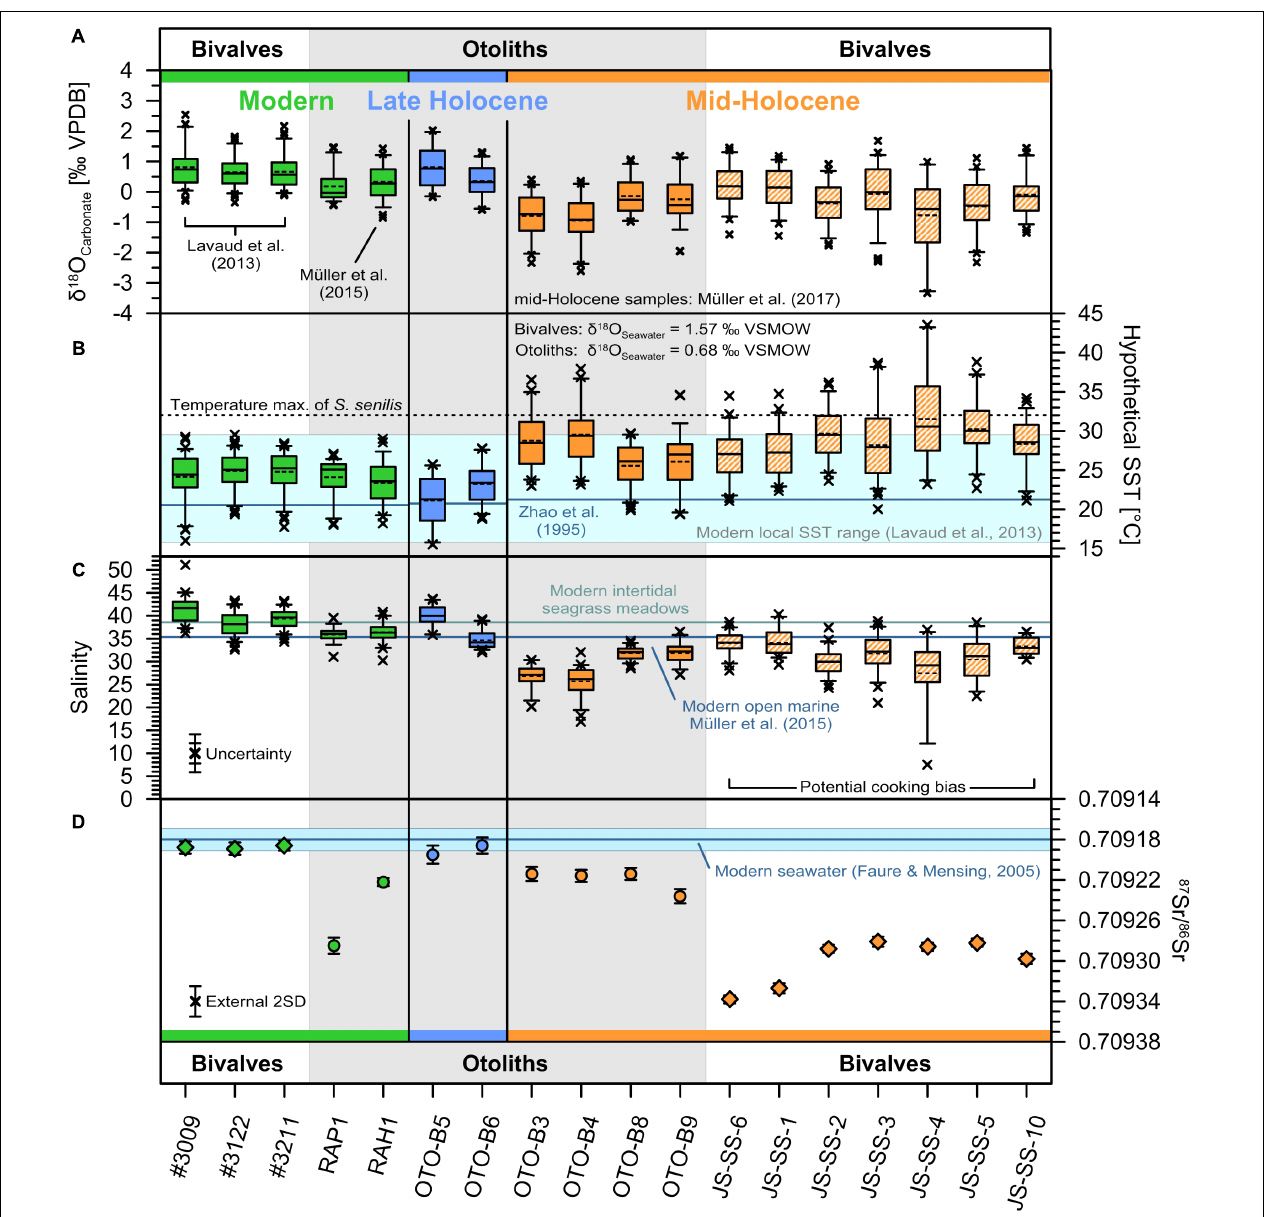
FIGURE 4 | Isotope records and proxy reconstructions of Mauritanian bivalve shells and otoliths. (A) Boxplot of measured bivalve shell and otolith δ 18 O data (grey demarcation) from previously published modern S. senilis for Banc d’Arguin, Mauritania (Lavaud et al., 2013), and the modern C. heudelotii otolith record from the Banc d’Arguin (Müller et al., 2015). Modern (2010–2012 AD) samples are shown in green, late Holocene (ca. 3.0 ka BP) otolith samples in blue, and mid-Holocene (ca. 5.3–5.0 ka BP) samples in orange. Striated boxes of the mid-Holocene bivalves δ 18 O data indicate potential minor alteration due to the exposure to prehistoric cooking methods prior to deposition (Müller et al., 2017). The box and whiskers represent the interquartile range and 5th/95th percentiles, respectively. The analytical uncertainty of the δ 18 O analysis is smaller than the symbol size ( ± 0.07 VPDB). Data points outside the whiskers represent statistical outliers. Solid and dotted horizontal lines inside the box show the median and average reconstructed water temperature values, respectively. (B) Boxplot of the hypothetical δ 18 O-derived SST (cid:104) assuming constant modern δ 18 O Seawater values with the modern seasonal water temperature range of the inner Banc d’Arguin from Lavaud et al. (2013) and the upper water temperature limit for S. senilis from Azzoug et al. (2012b) and the references therein for comparison. (C) Boxplot showing the reconstructed salinities using modern water temperature data and the different δ 18 O Seawater -salinity relationships ( Figure 6 ). The combined uncertainty includes the water temperature uncertainty of ± 1 ◦ C (inner error bars) and the potential misalignment accounting for on average 1.15 ◦ C (outer error bars). Horizontal lines represent the average modern salinity of the open Banc d’Arguin of 36.7 S p (Müller et al., 2015) and the intertidal areas in the eastern Banc d’Arguin of 40 S p (Lavaud et al., 2013). (D) Bulk 87 Sr/ 86 Sr records of modern and Holocene carbonate samples. Note that the y -axis is inverted to facilitate comparisons between 87 Sr/ 86 Sr records and δ 18 O-based salinity reconstructions. Sample error bars for 87 Sr/ 86 Sr indicate two standard errors (SE) of the mean. The external instrumental uncertainty is given as 2SD ( n = 263). The modern seawater composition of 0.70918 and corresponding 2SD ( ± 0.00001) (Faure and Mensing, 2005) are indicated by the horizontal line and shading,